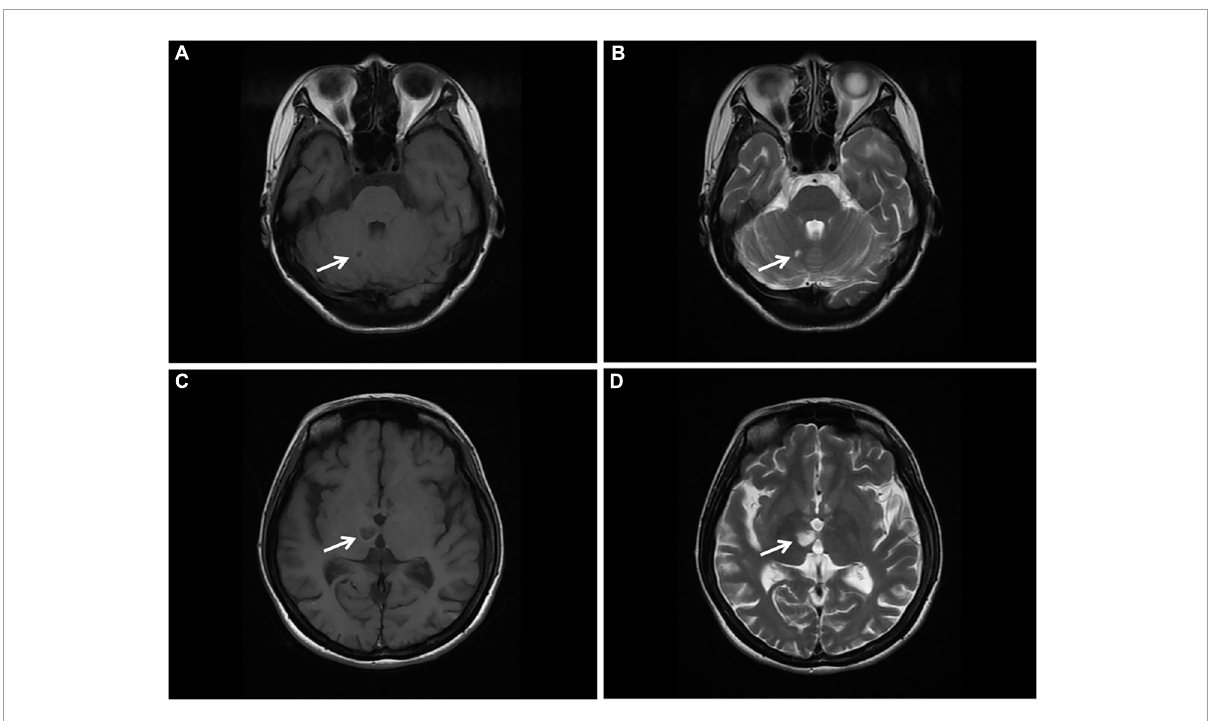
FIGURE1 Brain MRI. (A,B) T1 and T2 sequences showing cerebral infarction with a clear border in the right cerebellar hemisphere (arrow). (C,D) T1 and T2 sequences showing cerebral infarction with a clear border in the right thalamus. MRI, magnetic resonance imaging